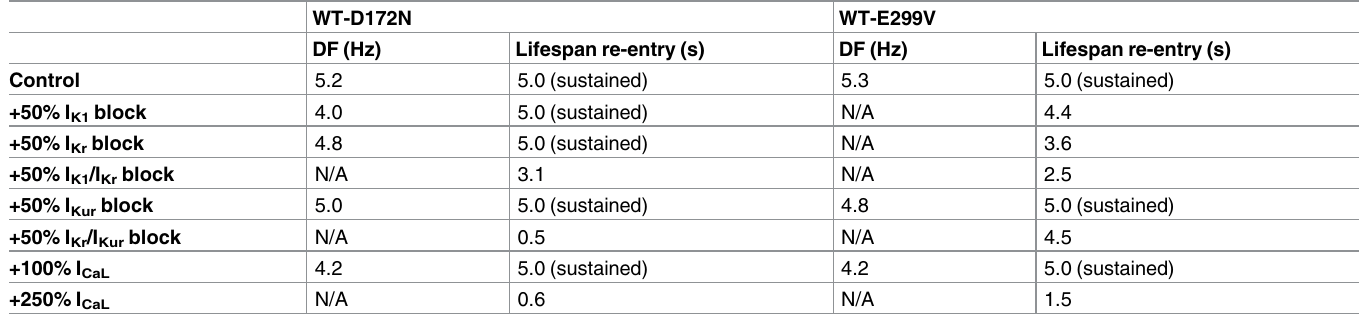
Table 3. A summary of simulated drug effects in the WT-D172N and WT-E299V conditions.